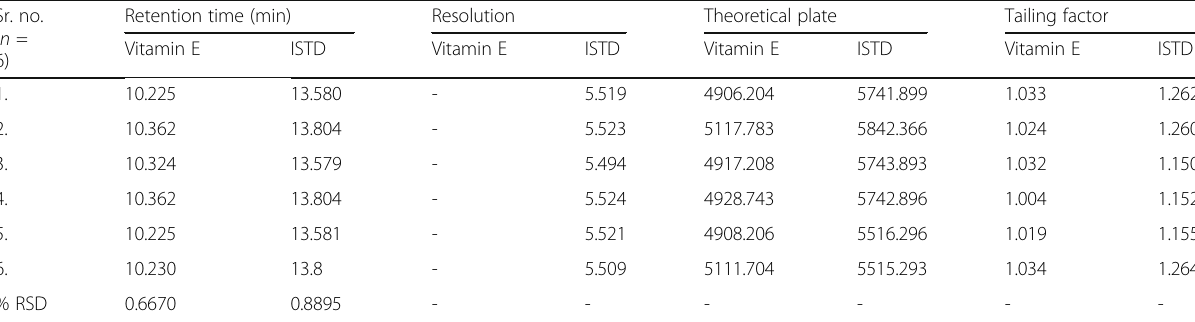
Table 1 System suitability parameters of developed bioanalytical method Sr. no. ( n =